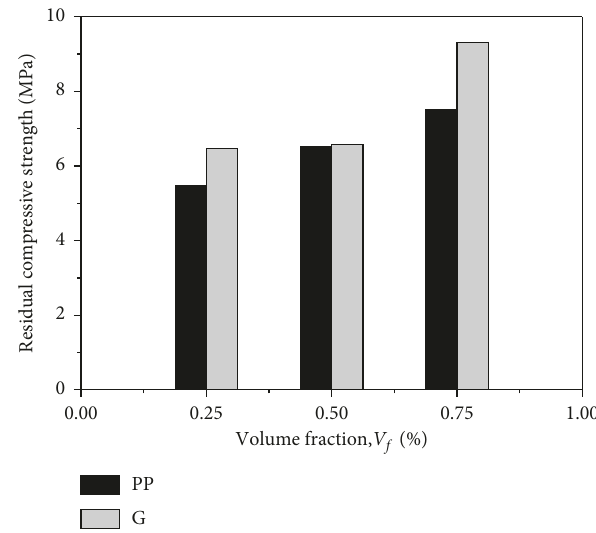
Figure 12: Residual compressive strength of concretes.